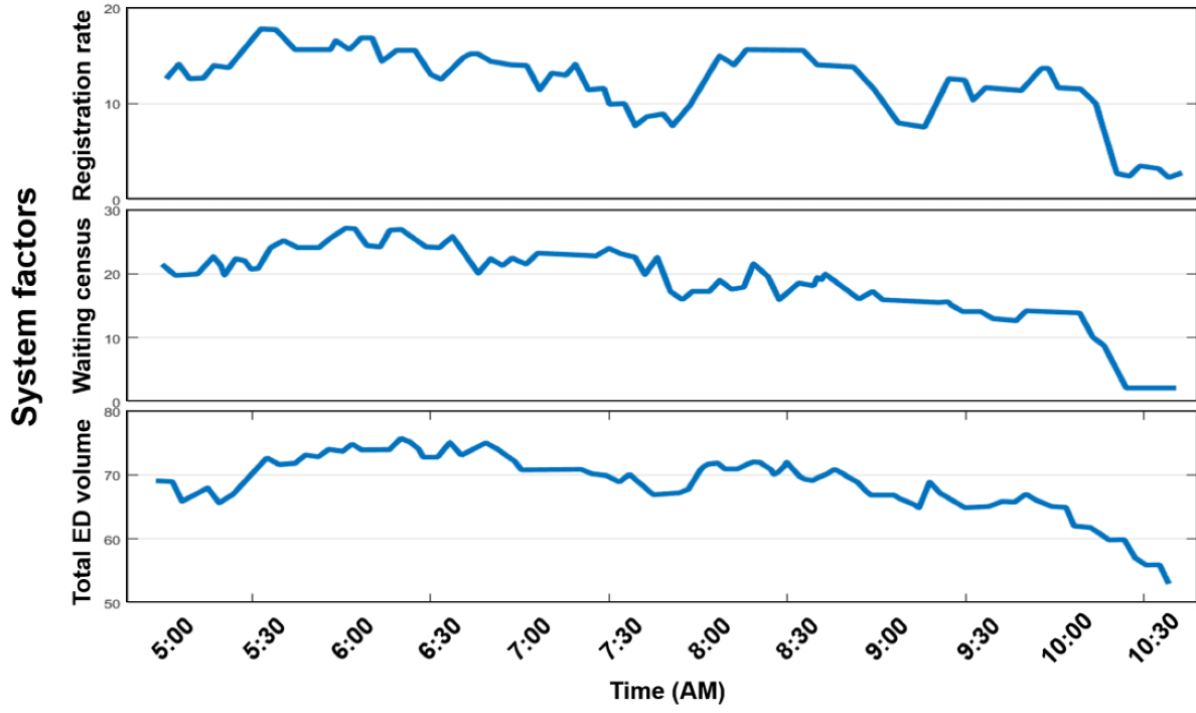
Figure 3. Emergency department context impacting the diagnostic process. ED: emergency